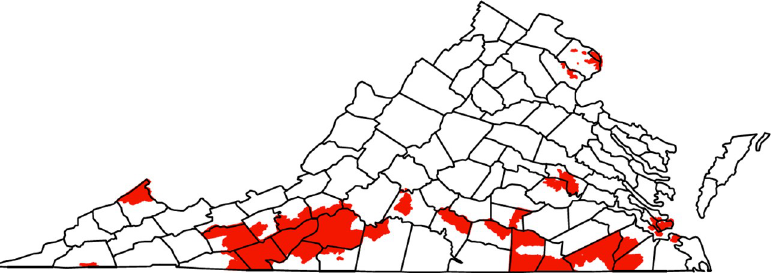
Fig 3. Census tracts most associated with increased likelihood of a TRO sales violation according to exceedance probabilities from the best fitting model with county boundaries included for